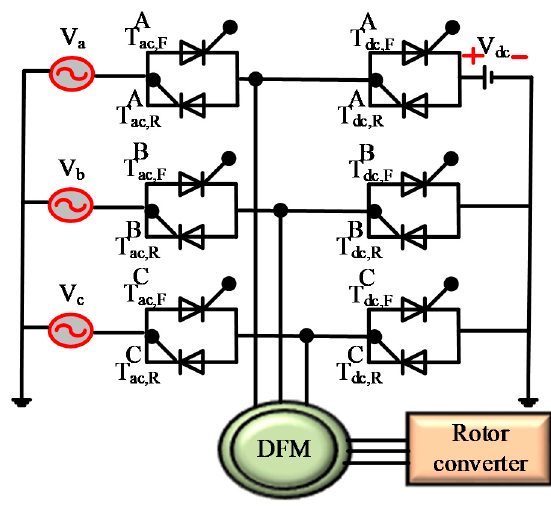
Figure 17. Schematic for three-phase SCR-based transfer switch connected to double fed machine [10].